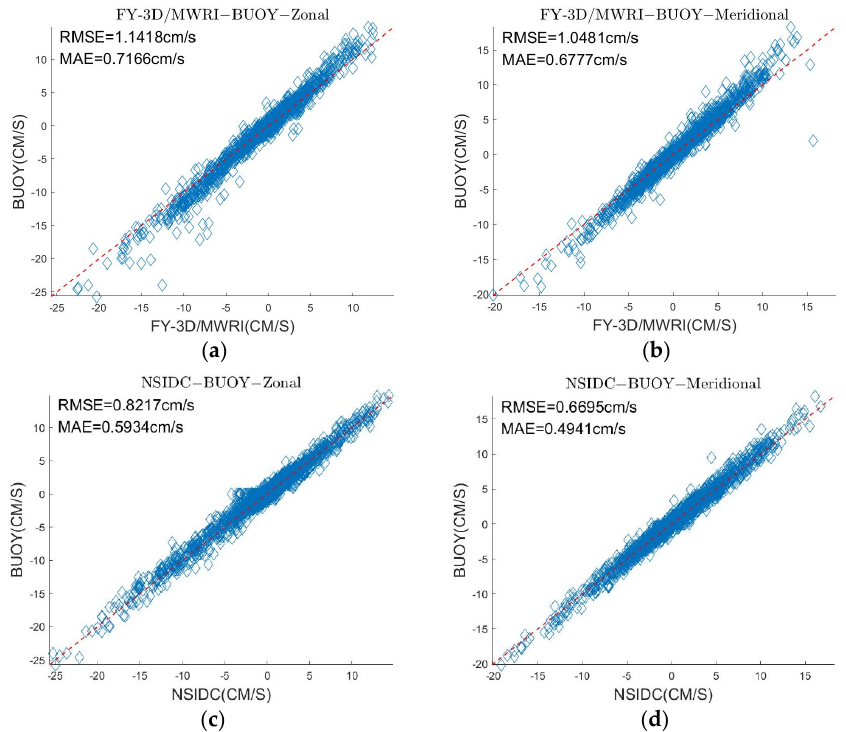
Figure 11. ( a ) is a comparison of the sea ice motion obtained by using FY-3D/MWRI T b data and the motion of the buoy in the zonal direction. ( b ) is a comparison of the sea ice motion retrieved by using FY-3D/MWRI T b data and the motion of the buoy in the meridional direction. ( c ) is a comparison of the sea ice motion obtained from the NSIDC and the motion of the buoy in the zonal direction. ( d ) is a comparison of the sea ice motion obtained from the NSIDC and the motion of the buoy in the meridional direction.